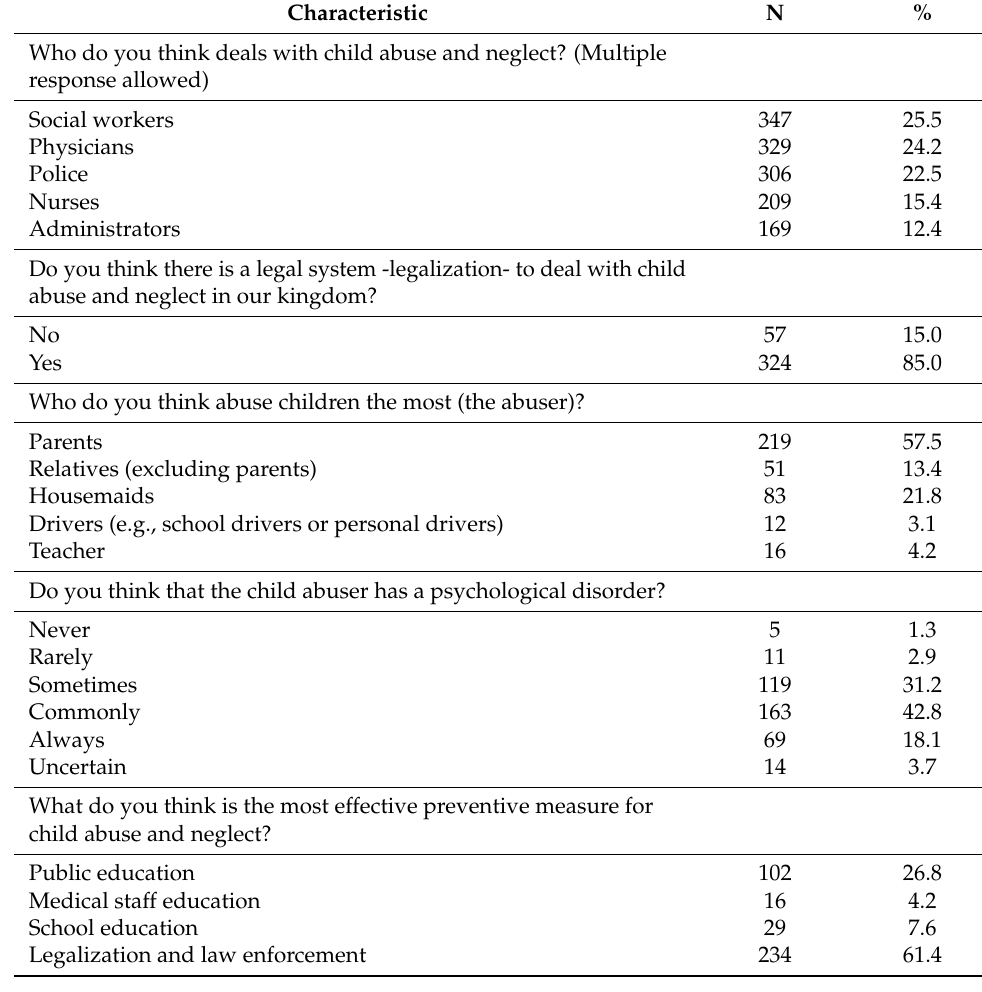
Table 4. Participant’s Response on the Legal Ways Child Abuse and Neglect Is Dealt and Preven- tive